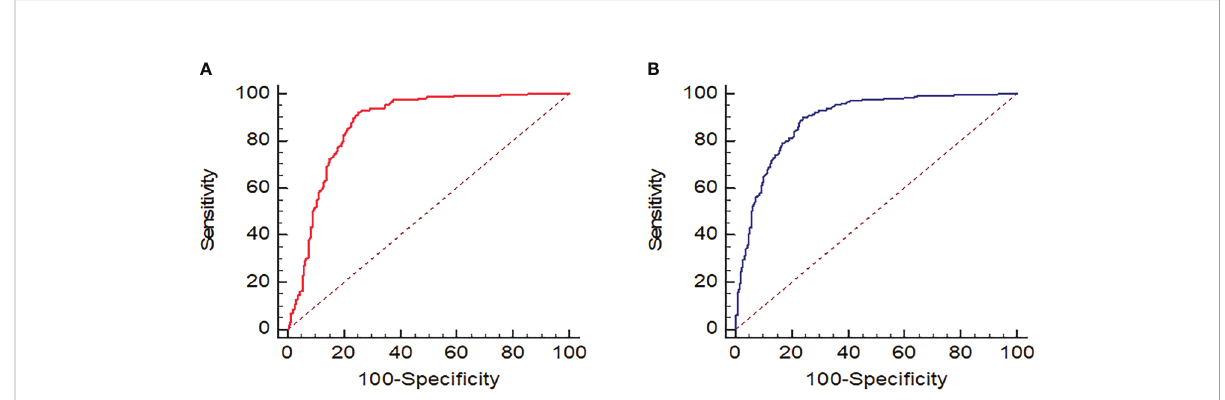
FIGURE 8 ROC of UGSR in differentiating between PTMCs and BMNs in patients with HT. (A) ROC of medical center A; (B) ROC of medical center